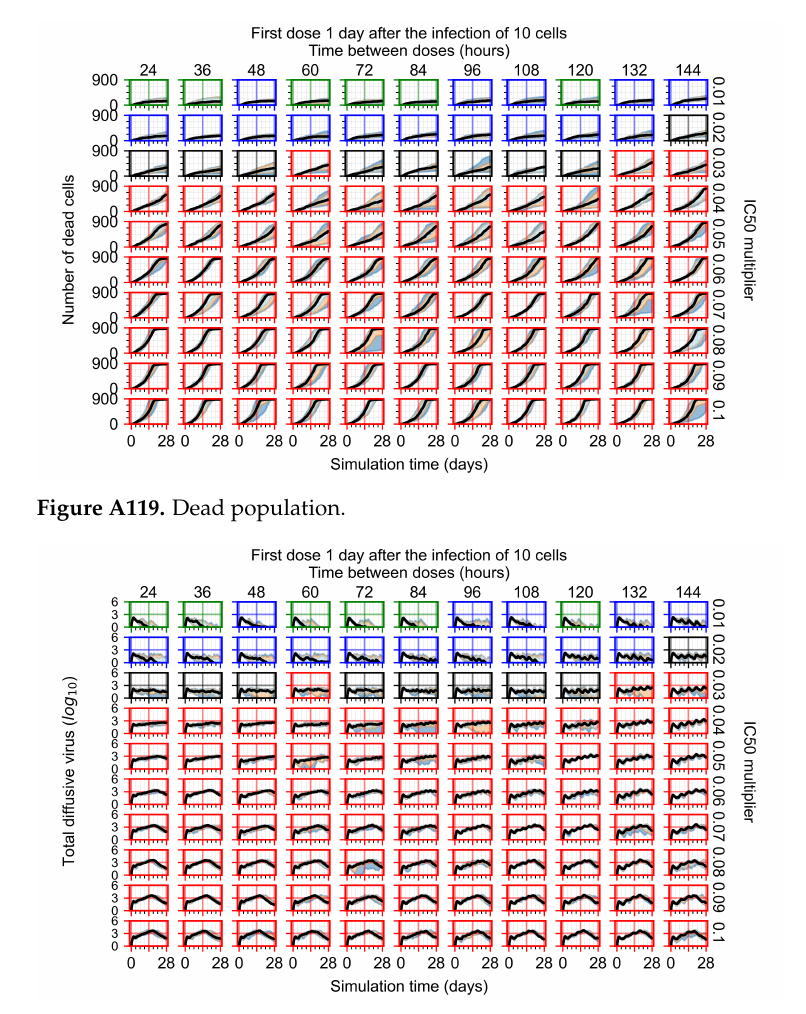
Figure A120. Extracellular diffusive virus quantities (arbitrary units), Y axis in log scale, and exponent values as tick marks.